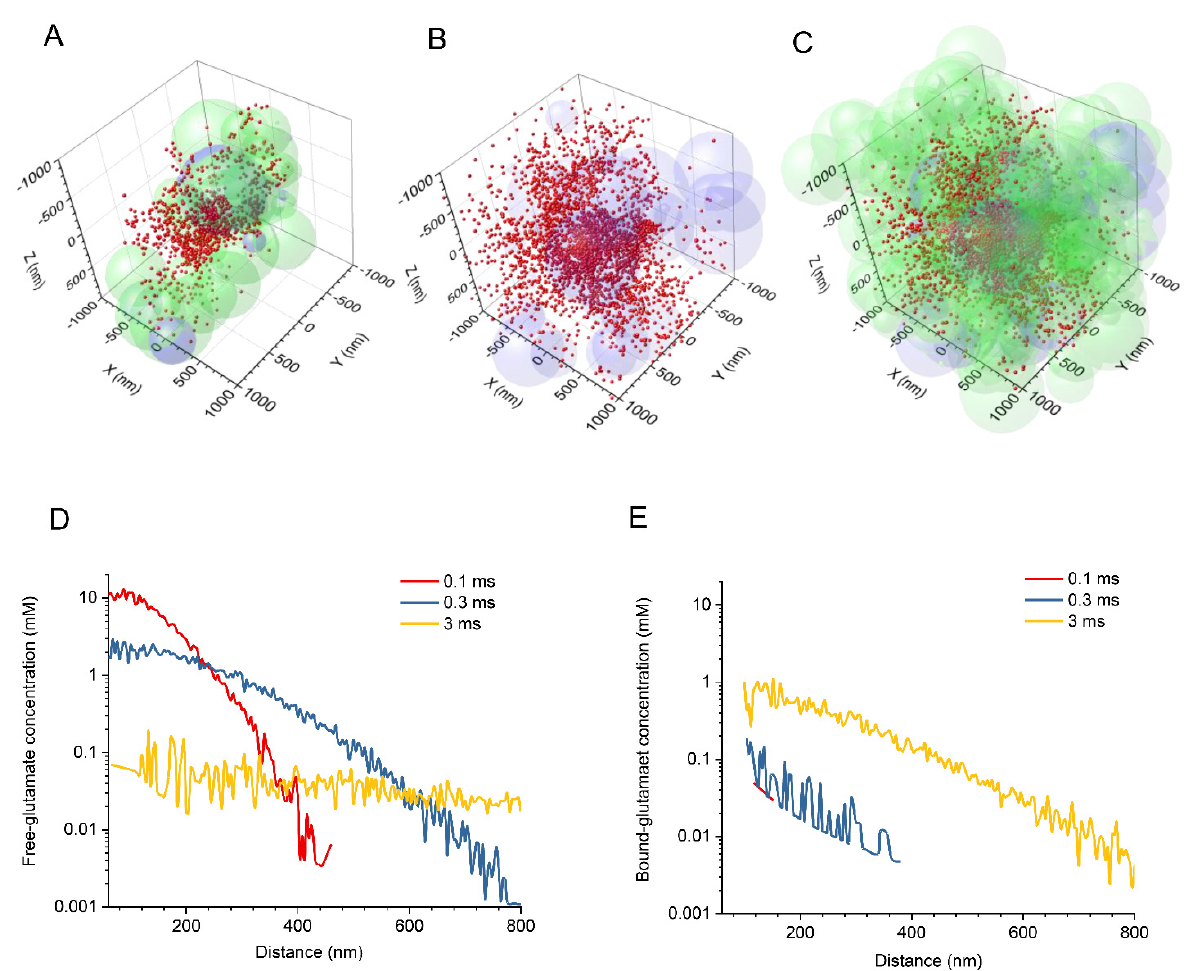
Figure 1. Exploring extrasynaptic glutamate escape in silico with a stochastic model of synaptic neuropil and Monte Carlo simulations. ( A – C ) Diagrams illustrating a snapshot of simulated glutamate particles (red dots) escaping the synaptic cleft at 1 ms post-release. The extracellular space is filled with overlapping spheres representing neuronal (light green) and astroglial (light magenta) structures. For clarity, the same data set is shown within a restricted volume slab ( A ), with astroglial elements only ( B ), and with all the components ( C ). The diagram shows a 2 µ m wide fragment of the 4 µ m wide simulation arena. Key model parameters: α = 0.2, free-diffusion D = 0.5 µ m 2 /ms, Ψ = 1 ms, astroglia fraction ~10%; number of molecules, 1000, average of n = 10 trials. ( D ) Simulated spatial profiles of the free glutamate concentrations, with respect to the cleft boundary (60 nm), at three time points post-release as indicated by colour code. ( E ) The same as in D but for the concentration of transporter-bound glutamate. Note that the distribution starts, on average, at ~20 nm outside the synaptic